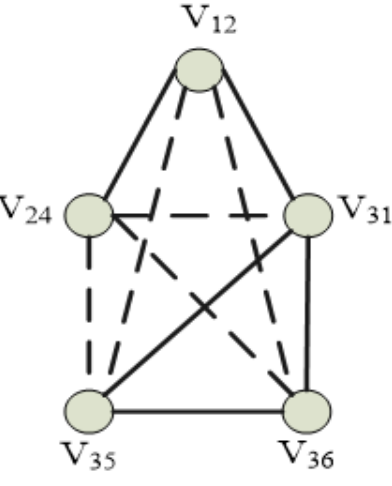
= ( V (cid:48) , E (cid:48) )